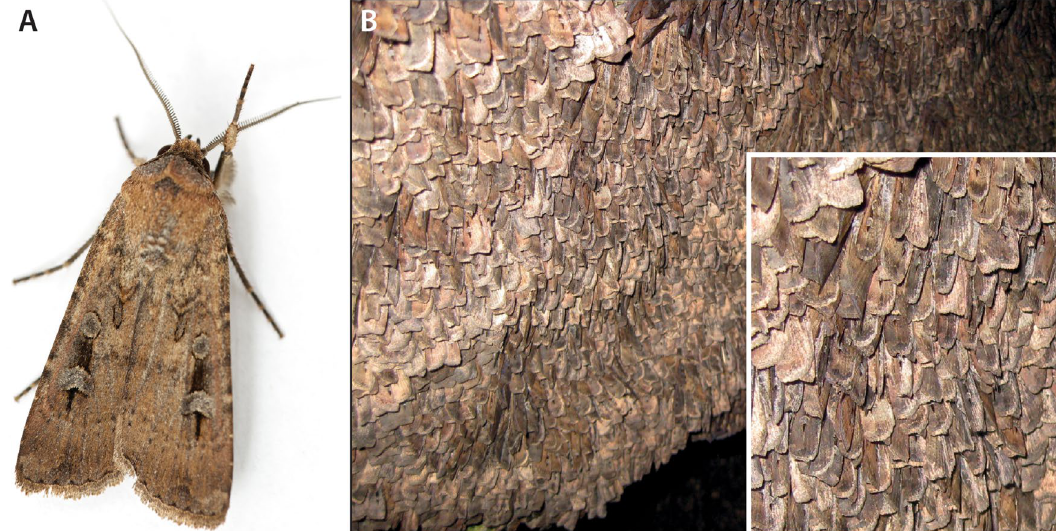
Figure 1. ( A ) Bogong moth, Agrotis infusa (photo: Ajay Narendra). ( B ) Thousands of moths per square metre aestivating on a rock surface (photo: Eric